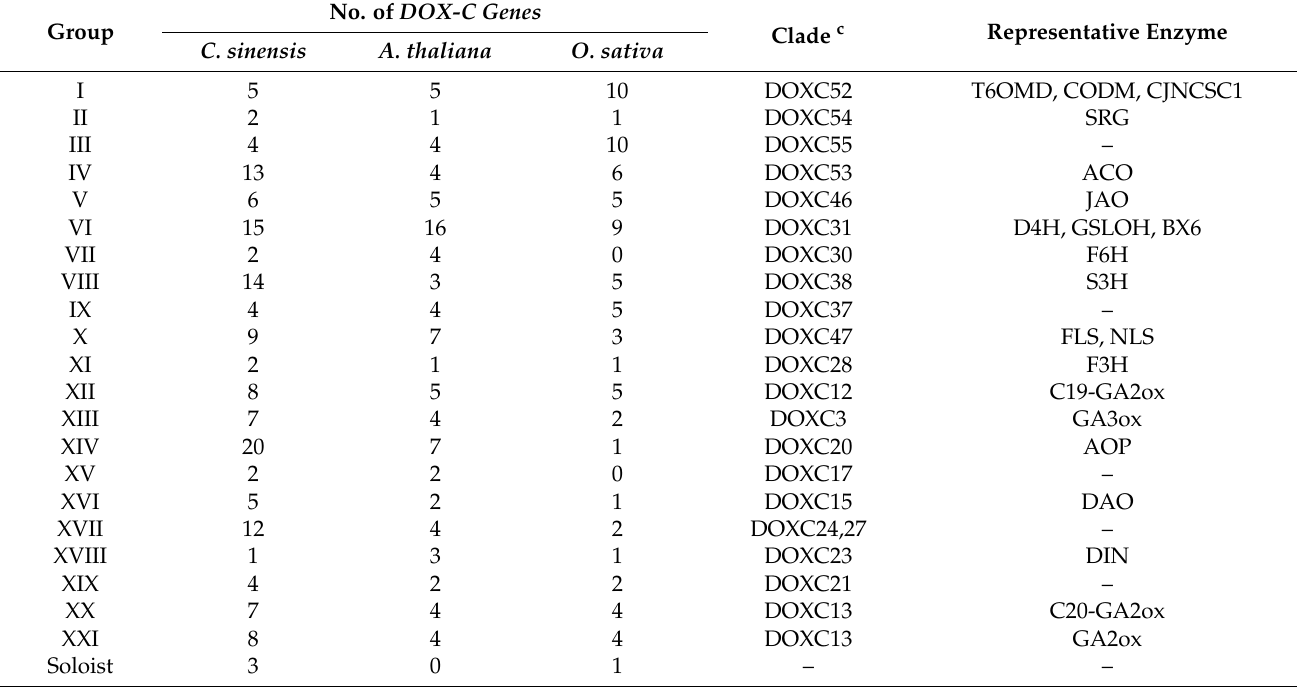
Table 1. The number of the DOX − C genes belonging to each